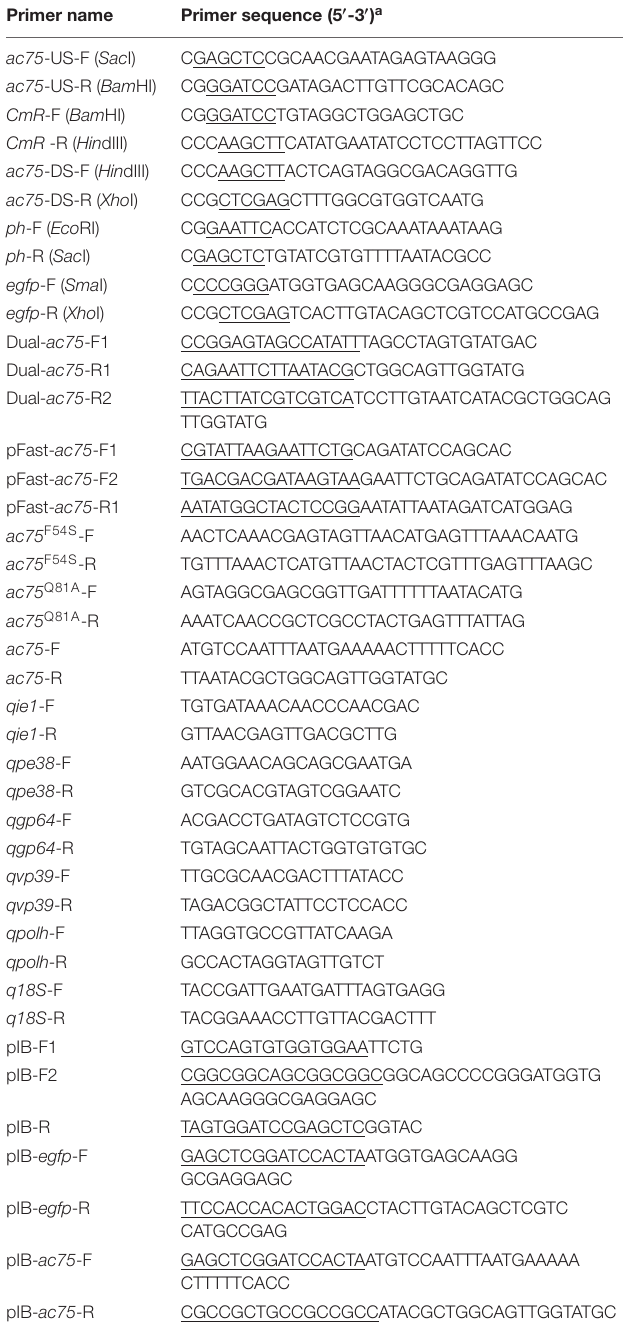
TABLE 1 | Primers used in this